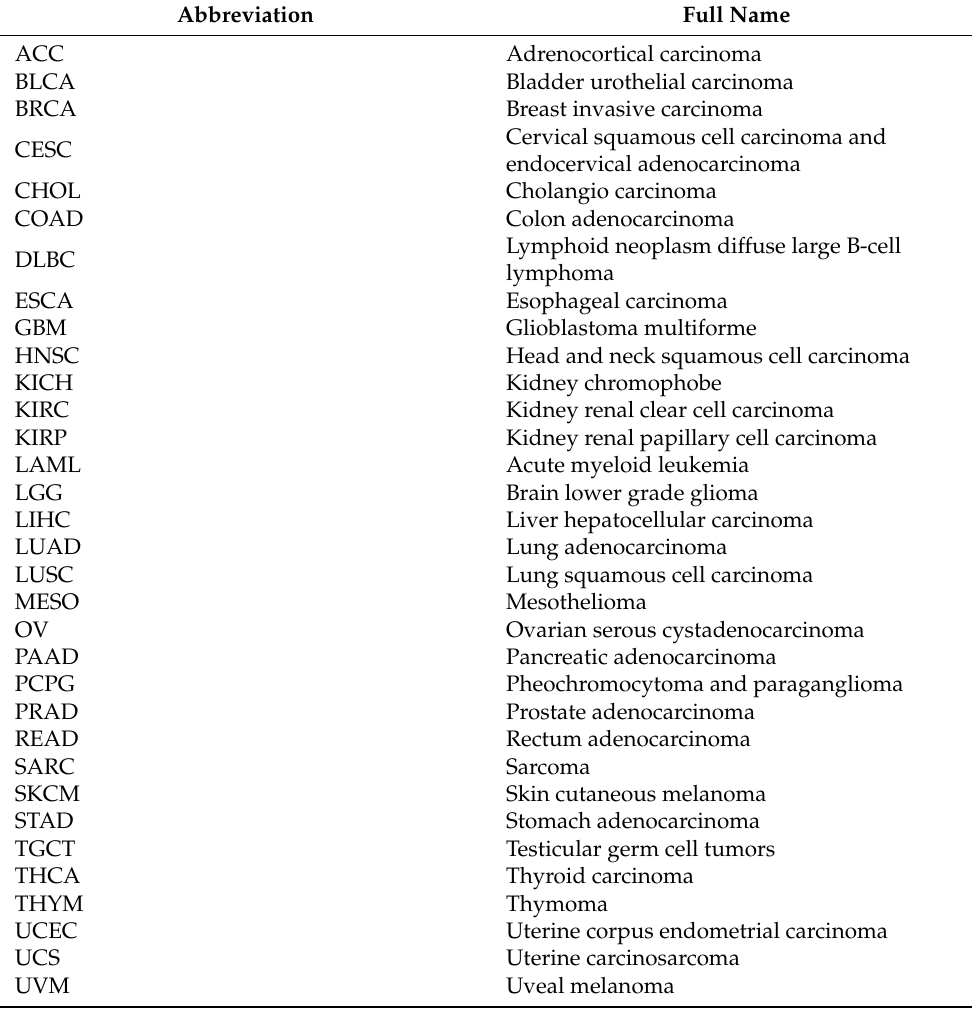
Table 1. The abbreviations and corresponding full names of various